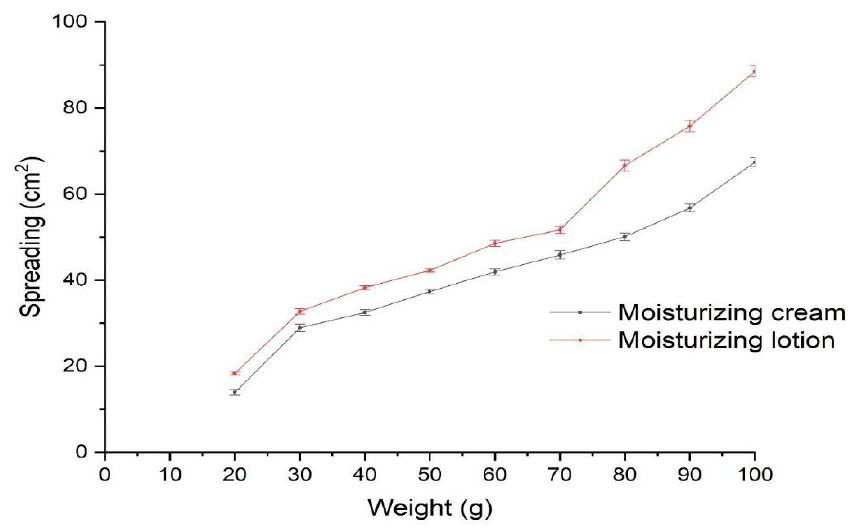
Figure 2. Spreadability behavior of the moisturizing cream (F4) and lotion (F5). 3.2.3. pH